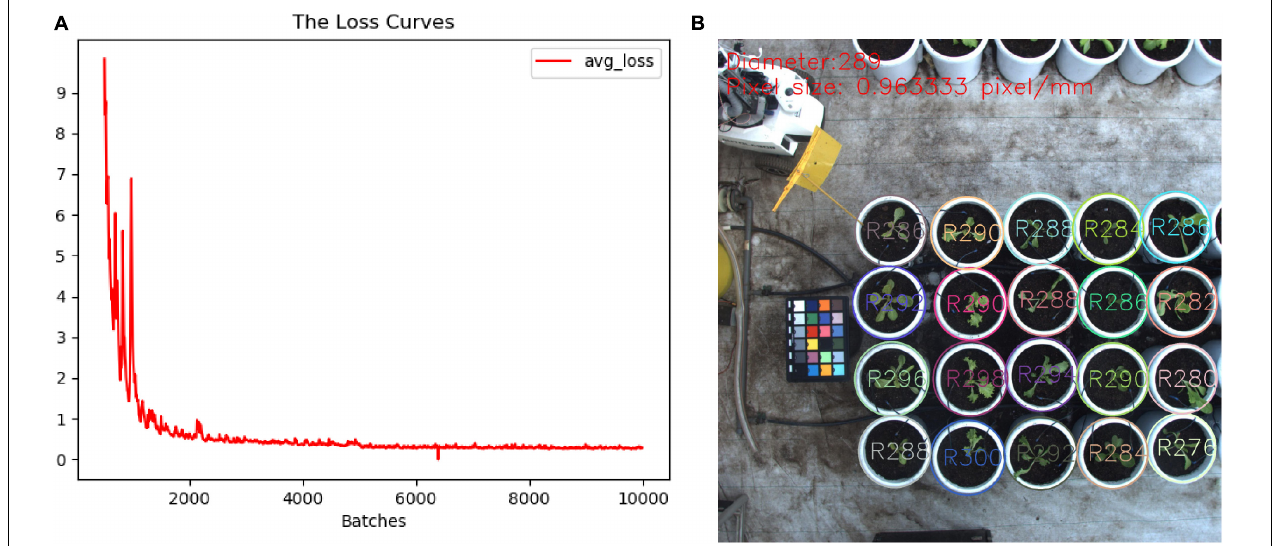
FIGURE 4 | Training detection model. (A) Loss curve. (B) Detected pots and their sizes in the input image.